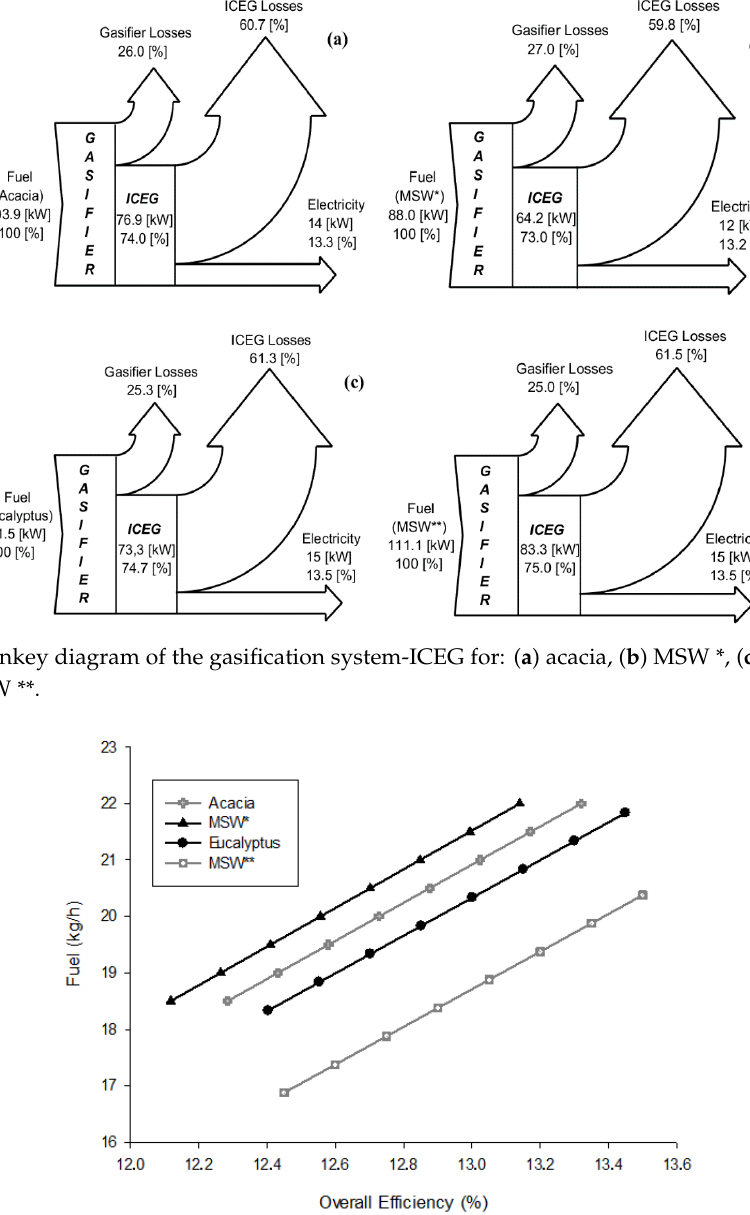
Figure 7. Effect of fuel feeding rate on the downdraft-ICEG system overall efficiency. Figure 7. E ff ect of fuel feeding rate on the downdraft-ICEG system overall e ffi